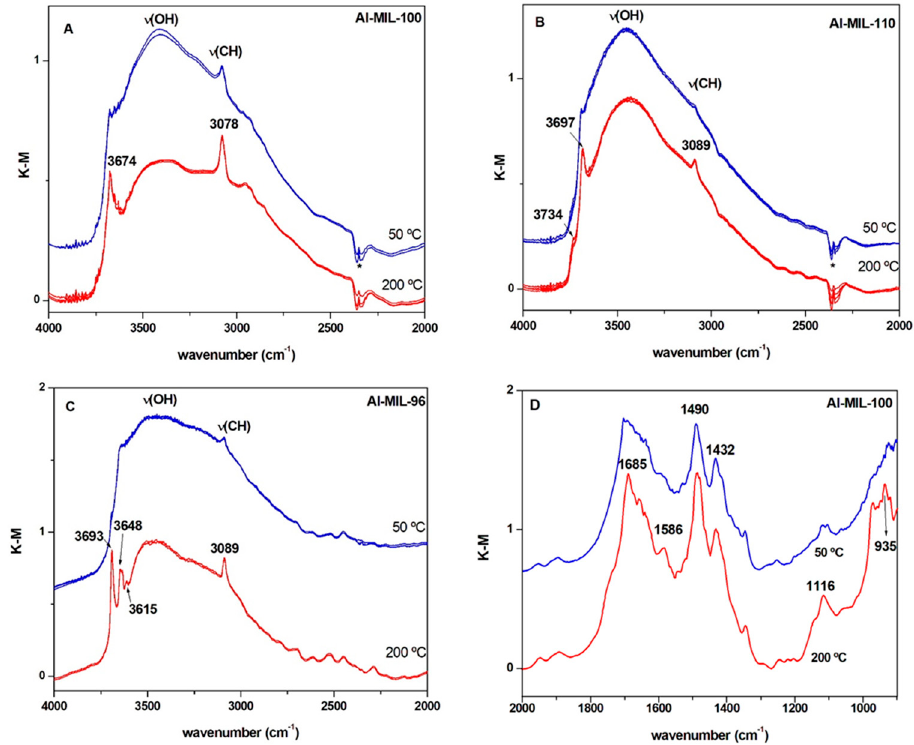
Figure 8. DRIFT spectra of following successive cycles of heating at 200 °C (red) and cooling at 50 °C (blue) in a stream of humid air of ( A ) MIL-100(Al), ( B ) MIL-110(Al) and ( C ) MIL-96(Al) materials. The overlapping of the spectra corresponding to four cycles indicates the good reproducibility of this thermal treatment. Panel ( D ) shows the DRIFT at lower wavenumber range, showing the structural bands of the linker, for MIL-100(Al) at 200 °C and 50 °C in wet airflow. The asterisk (*) marks the band of atmospheric CO 2 incompletely removed.